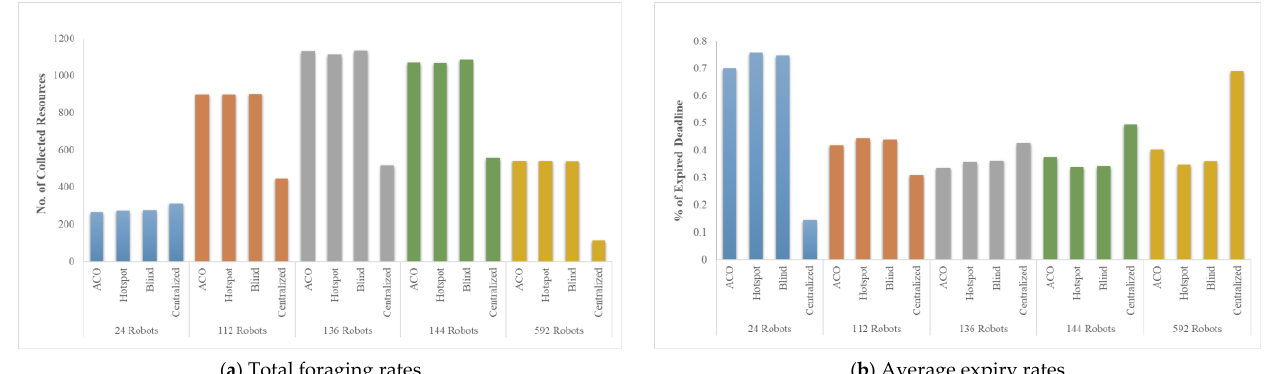
Figure 8. Average scalability of the different methods in terms of the ( a ) foraging and ( b ) expiry rates.